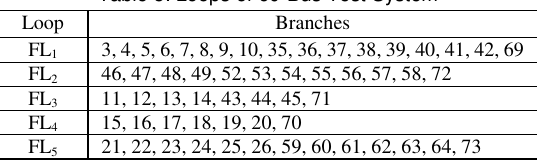
Table 5: Loops of 69-Bus Test System